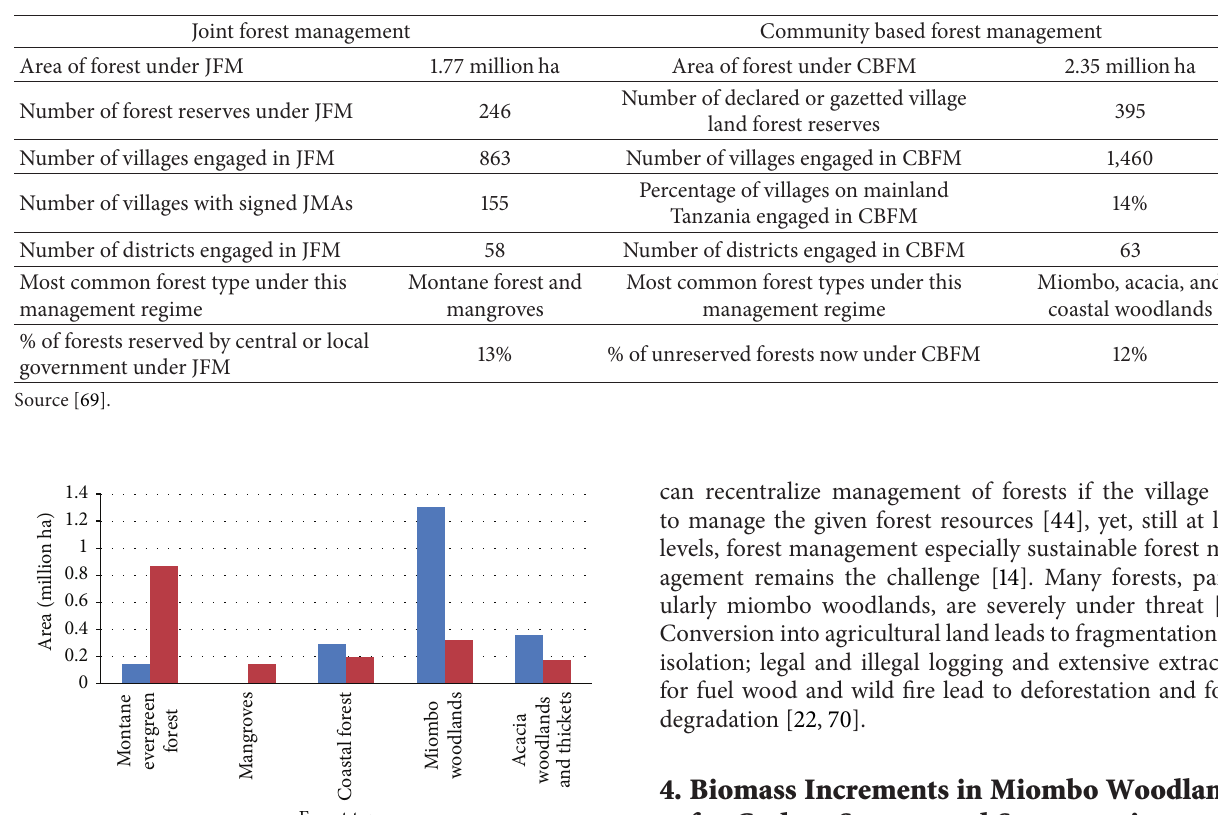
Table 3: The extend and coverage of participatory forest management regime in Tanzania.